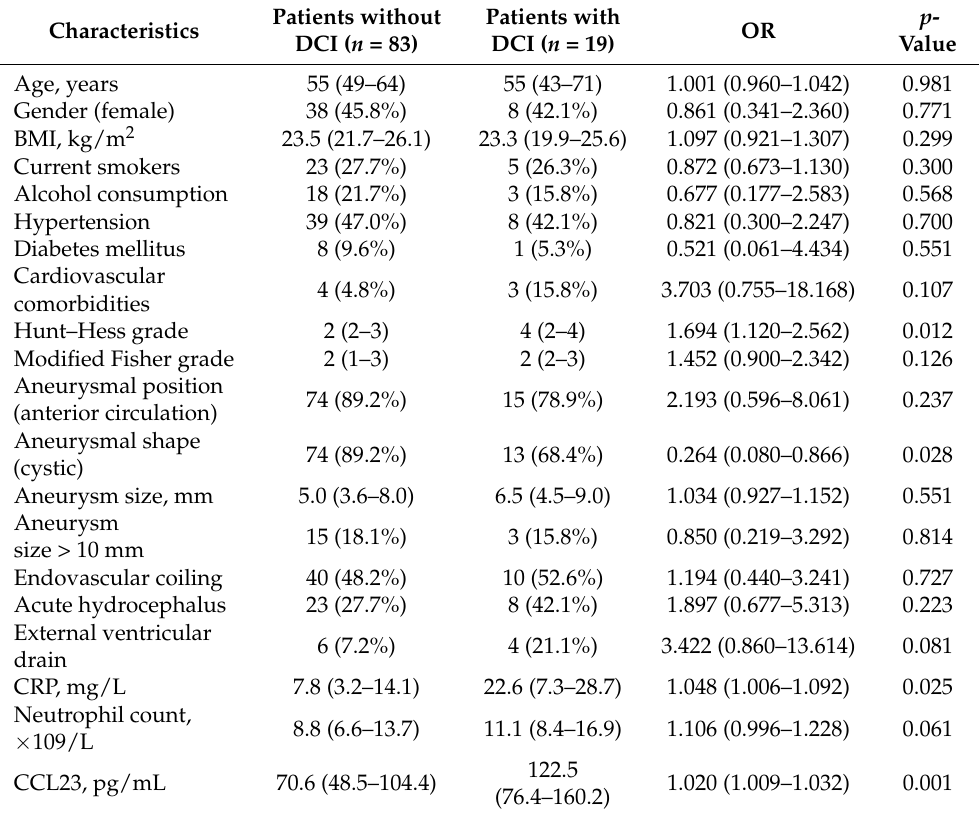
Table 2. Univariate logistic regression analysis of characteristics associated with DCI in patients with